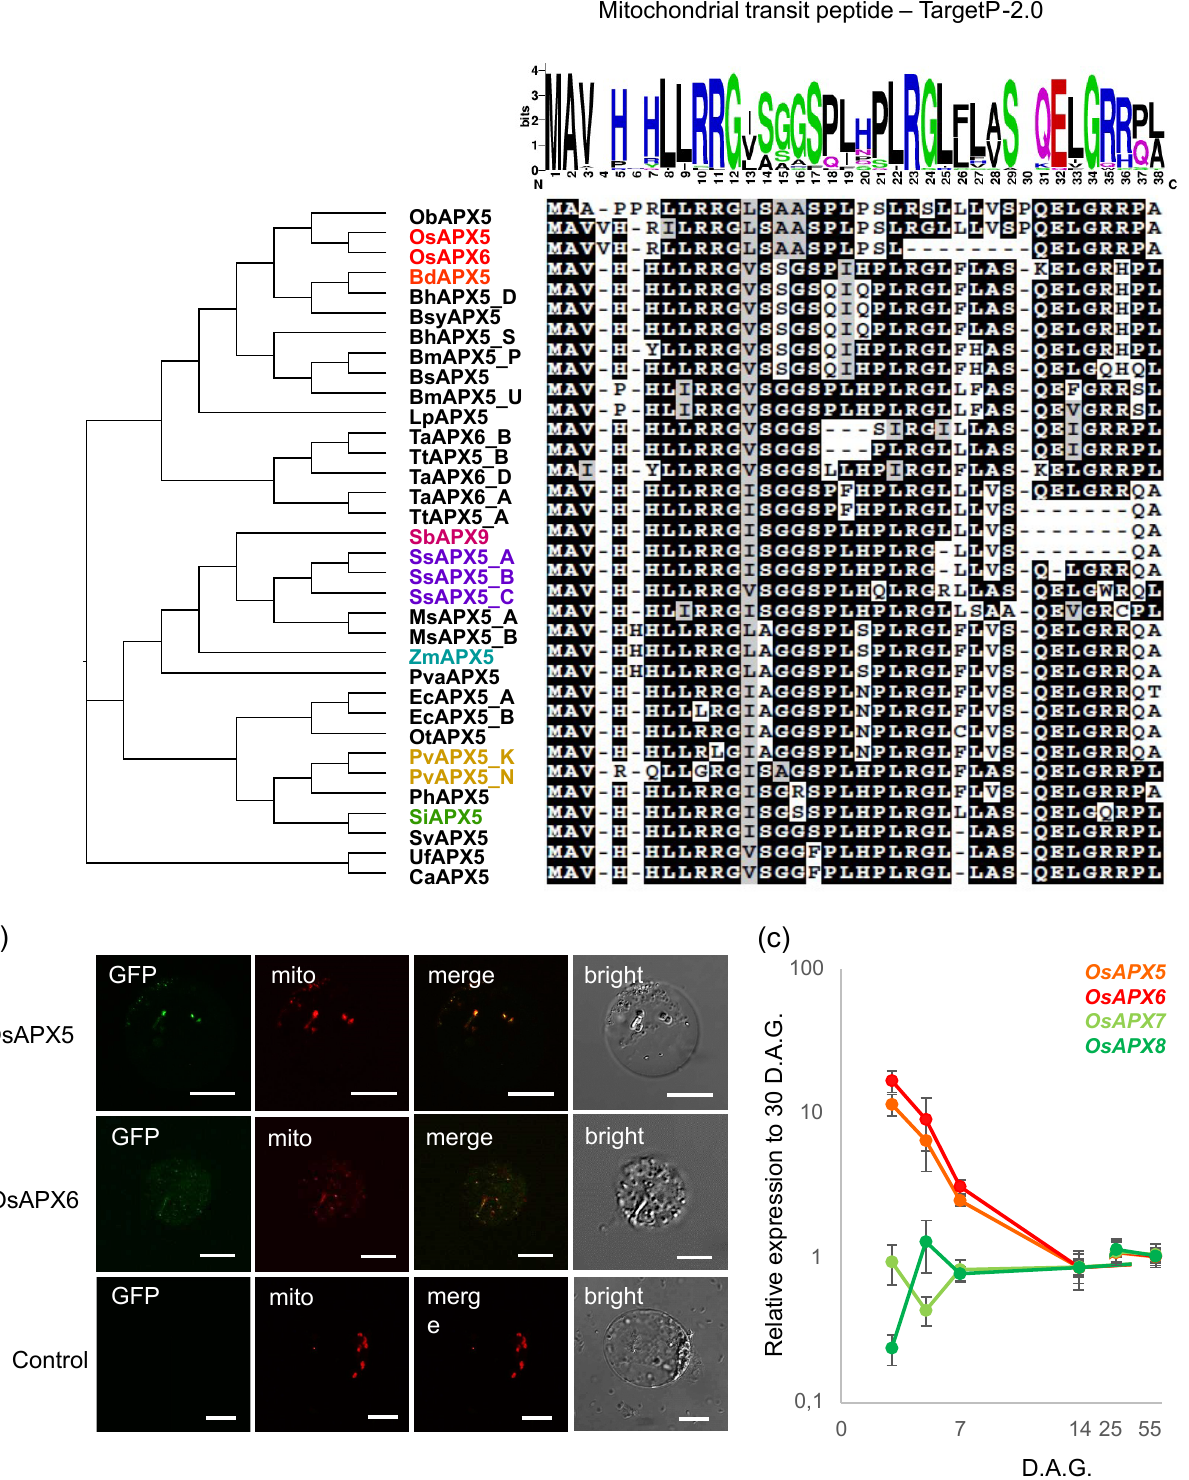
Figure 8 – Group IIIa APX are specific to Poacea specie and located in mitochondria. (A) Deduced amino acid alignment of predicted mitochondrial transit peptide of group IIIa APX from Poacea species. The sequences were aligned by Clustal Omega and the conserved amino acids are labeled in black. The phylogenetic relationship between APX, APX-R, APX-L was reconstructed using the maximal-likelihood method under the best model selection in IQ-TREE software with 1000 replicates of rapid bootstrap and aLRT statistics. The logos were identified by MEME software. The character and size of each logo represent the proportion of an amino acid at the specific site. (B) Subcellular localization of the OsAPX5 and OsAPX6 protein in rice etiolated protoplasts throught transient expression of the 35S-OsAPX5::YFP and 35S-OsAPX6::YFP. Green signals indicate YFP fluorescence; red signals indicate mitochondria location by MitoTracker fluorescence and yellow signals is the merged image. The negative control of YFP fluorescence is indicated. (C) Quantitative determination of OsAPX5 (orange), OsAPX6 (red), OsAPX7 (light green) and OsAPX8 (dark green) genes by RT-qPCR in shoot during rice development relative to 60 days after germination (D.A.G.) The values were normalized by at least three constitutive genes and represent the media ± SE of at least three independent